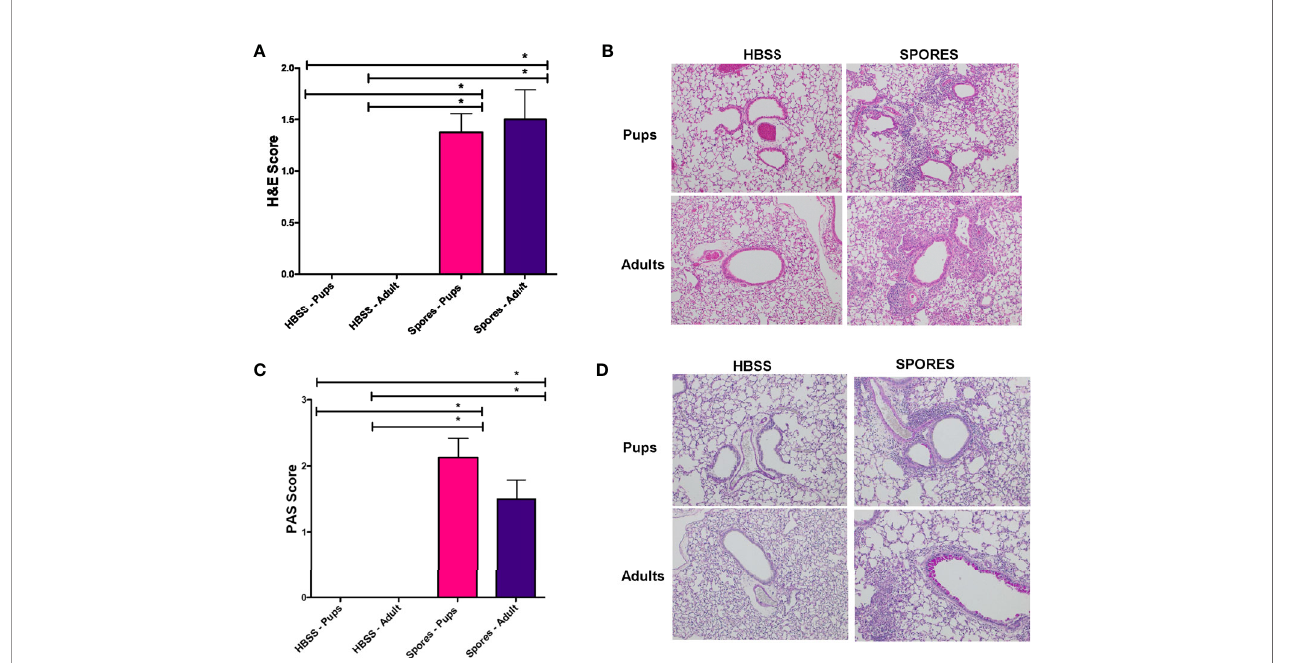
FIGURE 6 | Histology analyses of adults and neonates. *p < 0.05, n = 8. (A) H&E scores. (B) Example H&E images. (C) PAS scores. (D) Example PAS